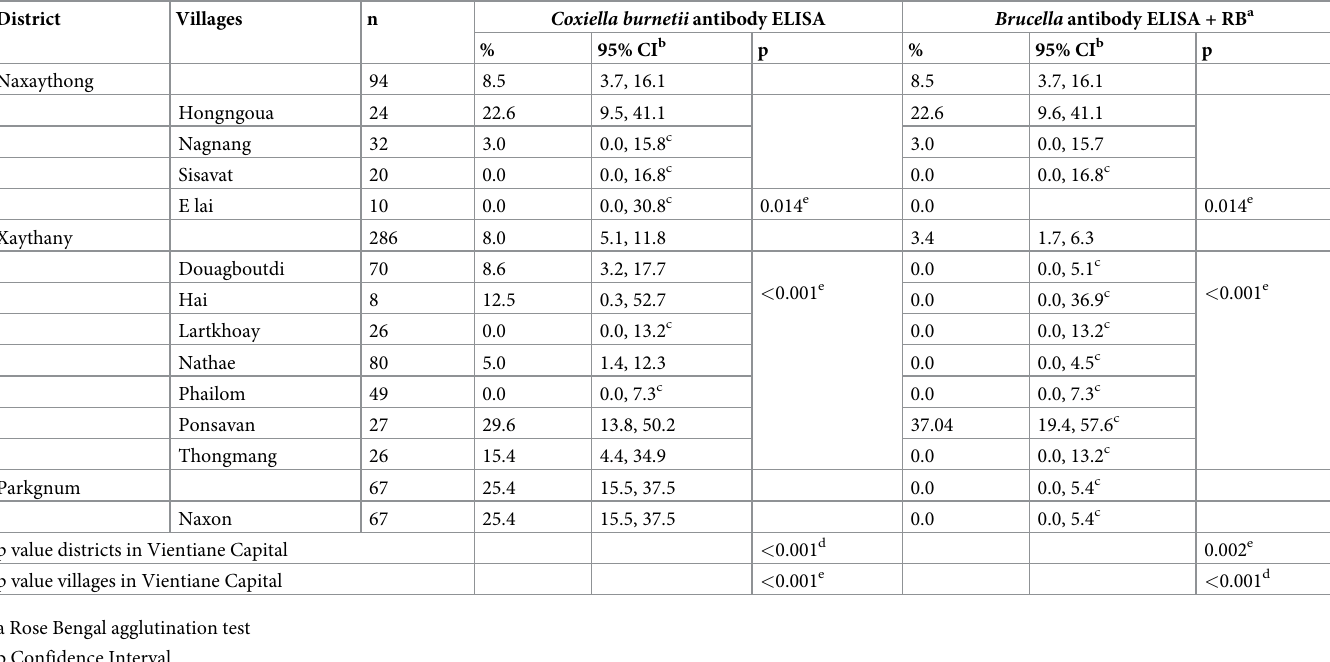
Table 3. C . burnetii and Brucella spp. seropositivity by district and village within Vientiane Capital.